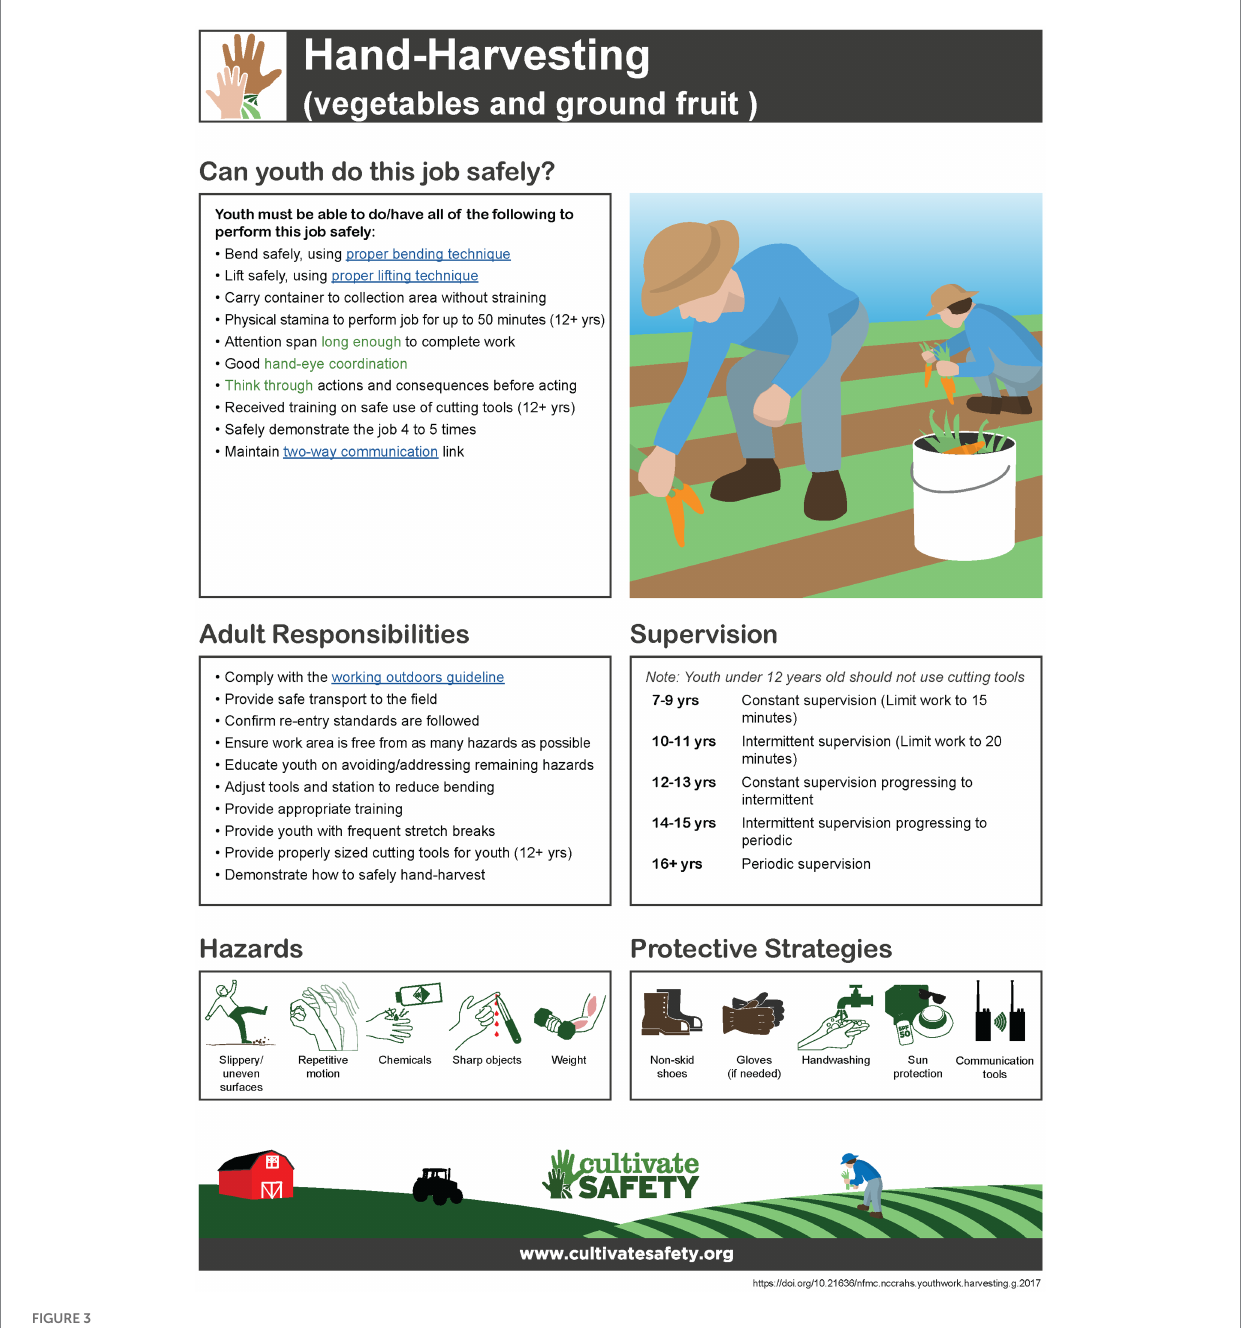
FIGURE 3 AYWG for hand-harvesting. Green text in the guideline provides pop-up definitions while blue underlined text links to supplemental materials. Published with permission from the National Children’s Center for Rural and Agricultural Health and